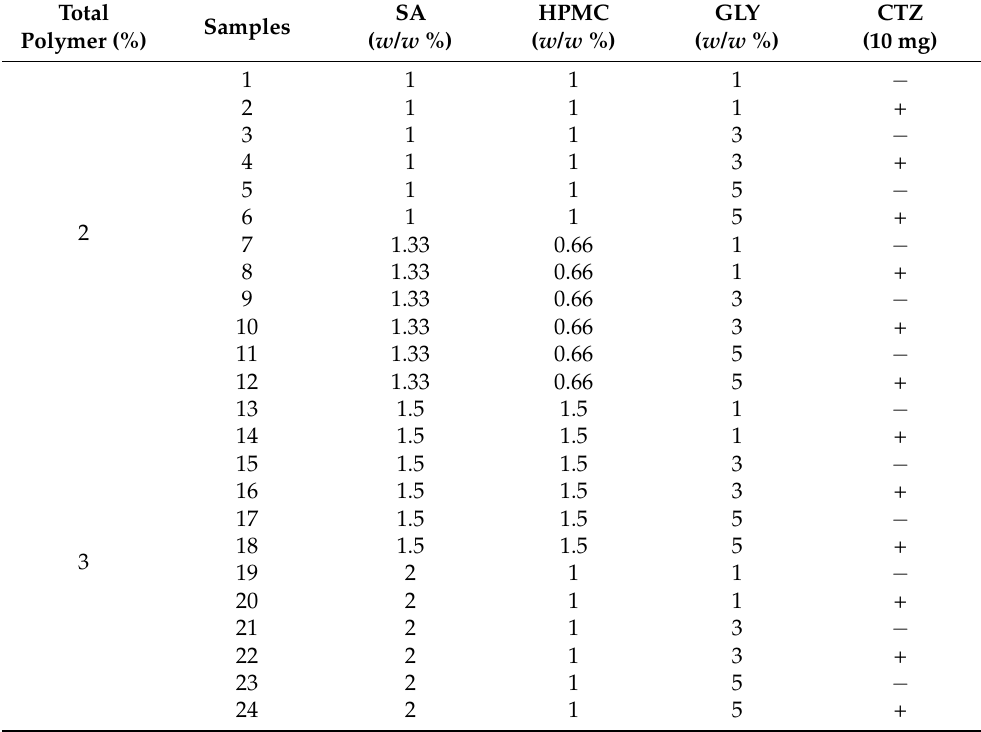
Table 1. Composition of the prepared SA-based